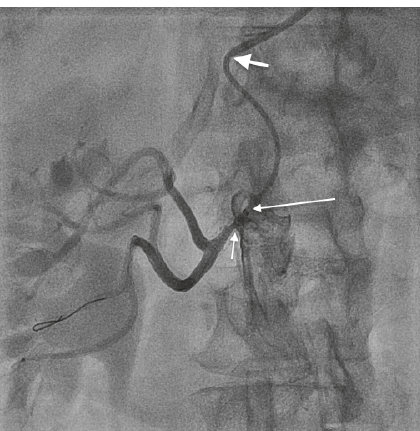
Figure 3: Good result after stenting (short arrow). Long arrow represents tip of the GuideLiner and thick arrow represents the tip of Multipurpose guide